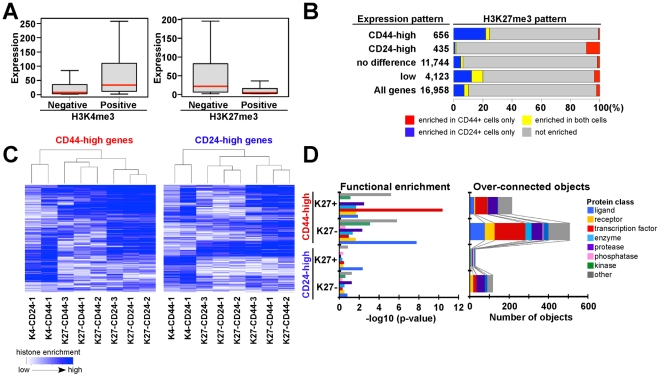
Associations between chromatin and cell type–specific expression patterns.(A) Overall correlation between histone methylation (K4, K27) and gene expression in CD44+ progenitors from sample 1. Box plot shows distribution of gene expression of corresponding genes in each category. Red bar: median, box: interquartile ranges and whisker; most extreme value within 1.5 times of box length. (B) Bar chart shows the correlation between cell type–specific K27 enrichment and gene expression patterns. Blue and red: K27-enriched only in CD24+ and CD44+ cells, respectively, yellow and gray: K27 enriched in both and neither cell type. (C) Differences in K27 patterns between CD24+ and CD44+ cells are consistent in three individual samples and distinct from that of K4 profiles. Heatmap depicting unsupervised clustering of histone modification patterns of genes highly expressed in CD44+ (656 genes) and CD24+ (435 genes) cells. Blue color indicates the level of enrichment for the indicated histone modification based on the ranking of ChIP-Seq read counts for each gene in each sample. (D) Differentially expressed genes that are enriched (K27+) or not enriched (K27-) for K27 were analyzed for relative enrichment with the indicated protein classes (left panel) and for relative connectivity (right panel). X-axes indicate –log10 p-values for enrichment with the listed protein classes (left panel) and the number of overconnected objects, defined as proteins with higher than expected number of interactions, in each functional category within each group (right panel), respectively.